Question: In a single sentence, describe what this figure presents.
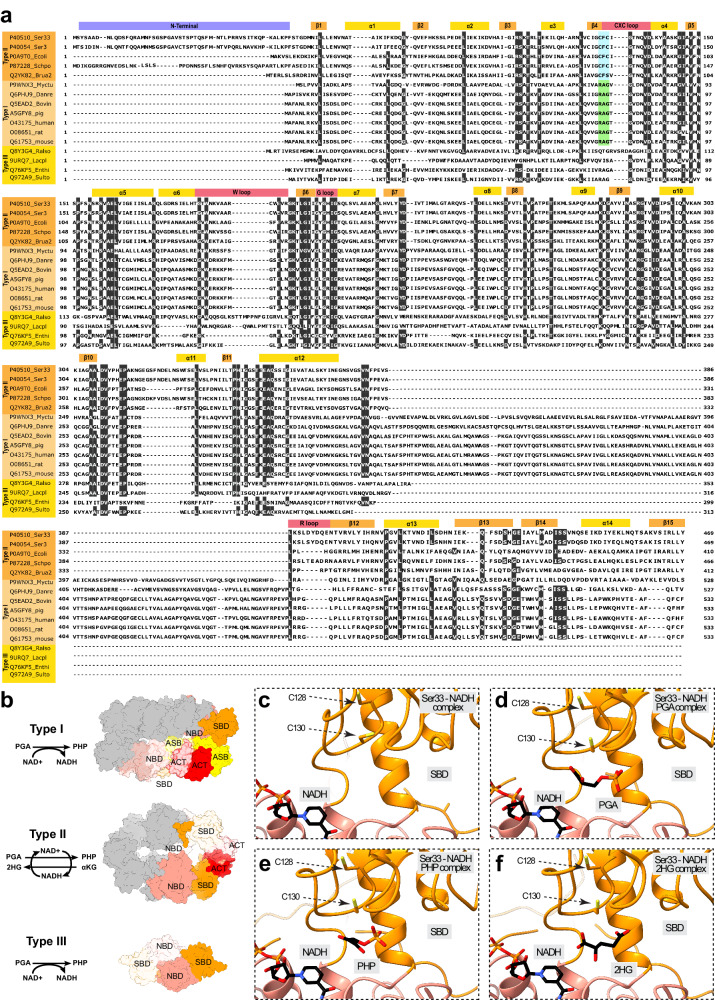
Answer: Structure-based sequence alignment of Ser33 and homologs. a Comparison of the Type II PHGDH from S. cerevisiae , Ser33 ( P40510 UniProt code hereafter), with other Type II PHGDHs, S. cerevisiae Ser3 ( P40054 ), E. coli ( P0A9T0 ), Schizosaccharomyces pombe ( P87228 ), and Brucella abortus (Q2YK82), Type I PHGDHs from M. tuberculosis ( P9WNX3 ), Danio rerio (Q6PHU9), Bos taurus ( Q5EAD2 ), Sus scrofa ( A5GFY8 ), H. sapiens ( O43175 ), Rattus norvegicus ( O08651 ), and Mus musculus ( Q61753 ) and Type III PHGDHs from Ralstonia solanacearum (Q8Y3G4), Lactobacillus plantarum (F9URQ7), E. histolytica (Q76KF5) and Sulfolobus tokodaii (Q972A9; see Methods). The distribution of secondary structure elements of Ser33 is displayed above the alignment. The CXC and RAG motifs identified in Type II and Type I PHGDHs are shown in blue and green, respectively. b A scheme of the structural arrangement of Type I, II, and III PHGDHs is shown. Close-up view of the CXC motif in the Ser33-NADH ( c ), Ser33-NADH-PGA ( d ), Ser33-NADH-PHP ( e ), and Ser33-NADH-2HG ( f ) complexes.